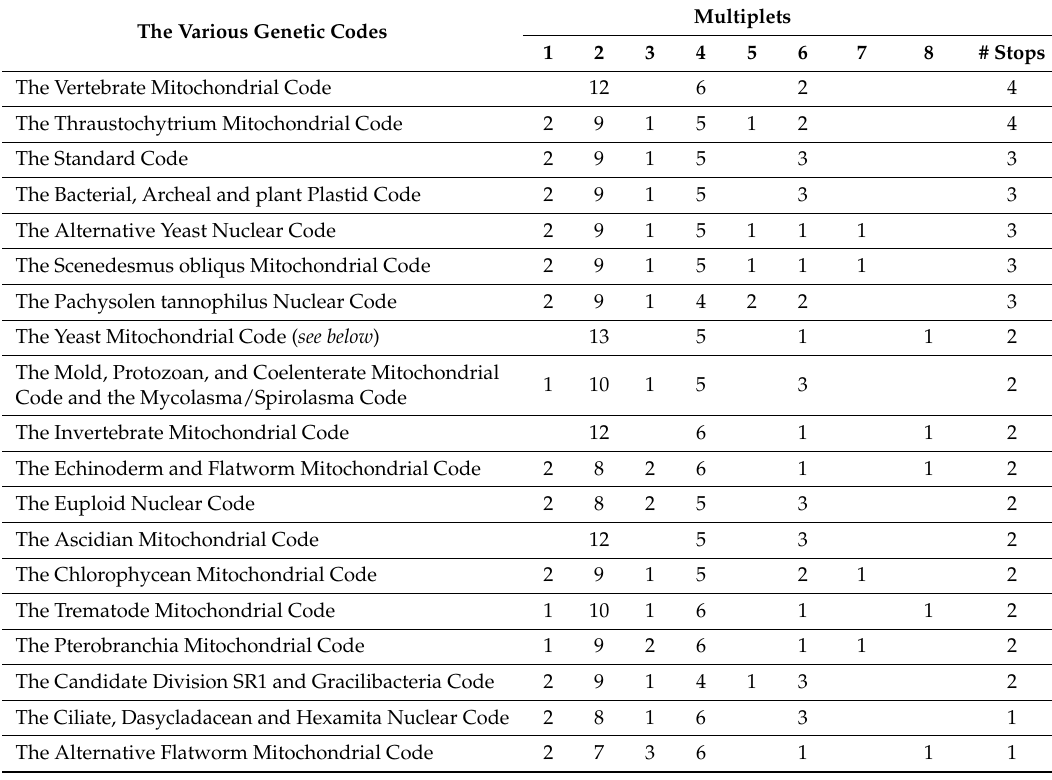
Table 1. The distribution of codons in the various genetic